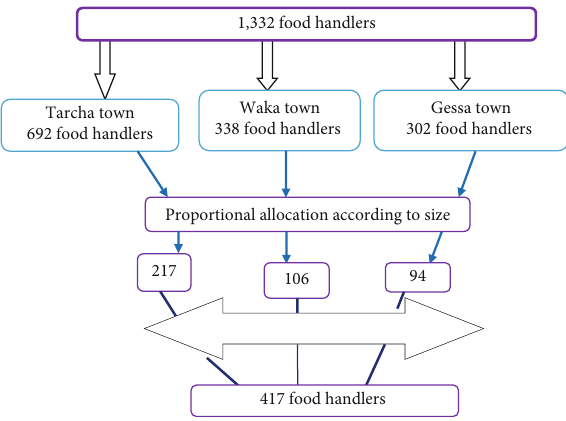
Figure 1: Flow chart of sampling